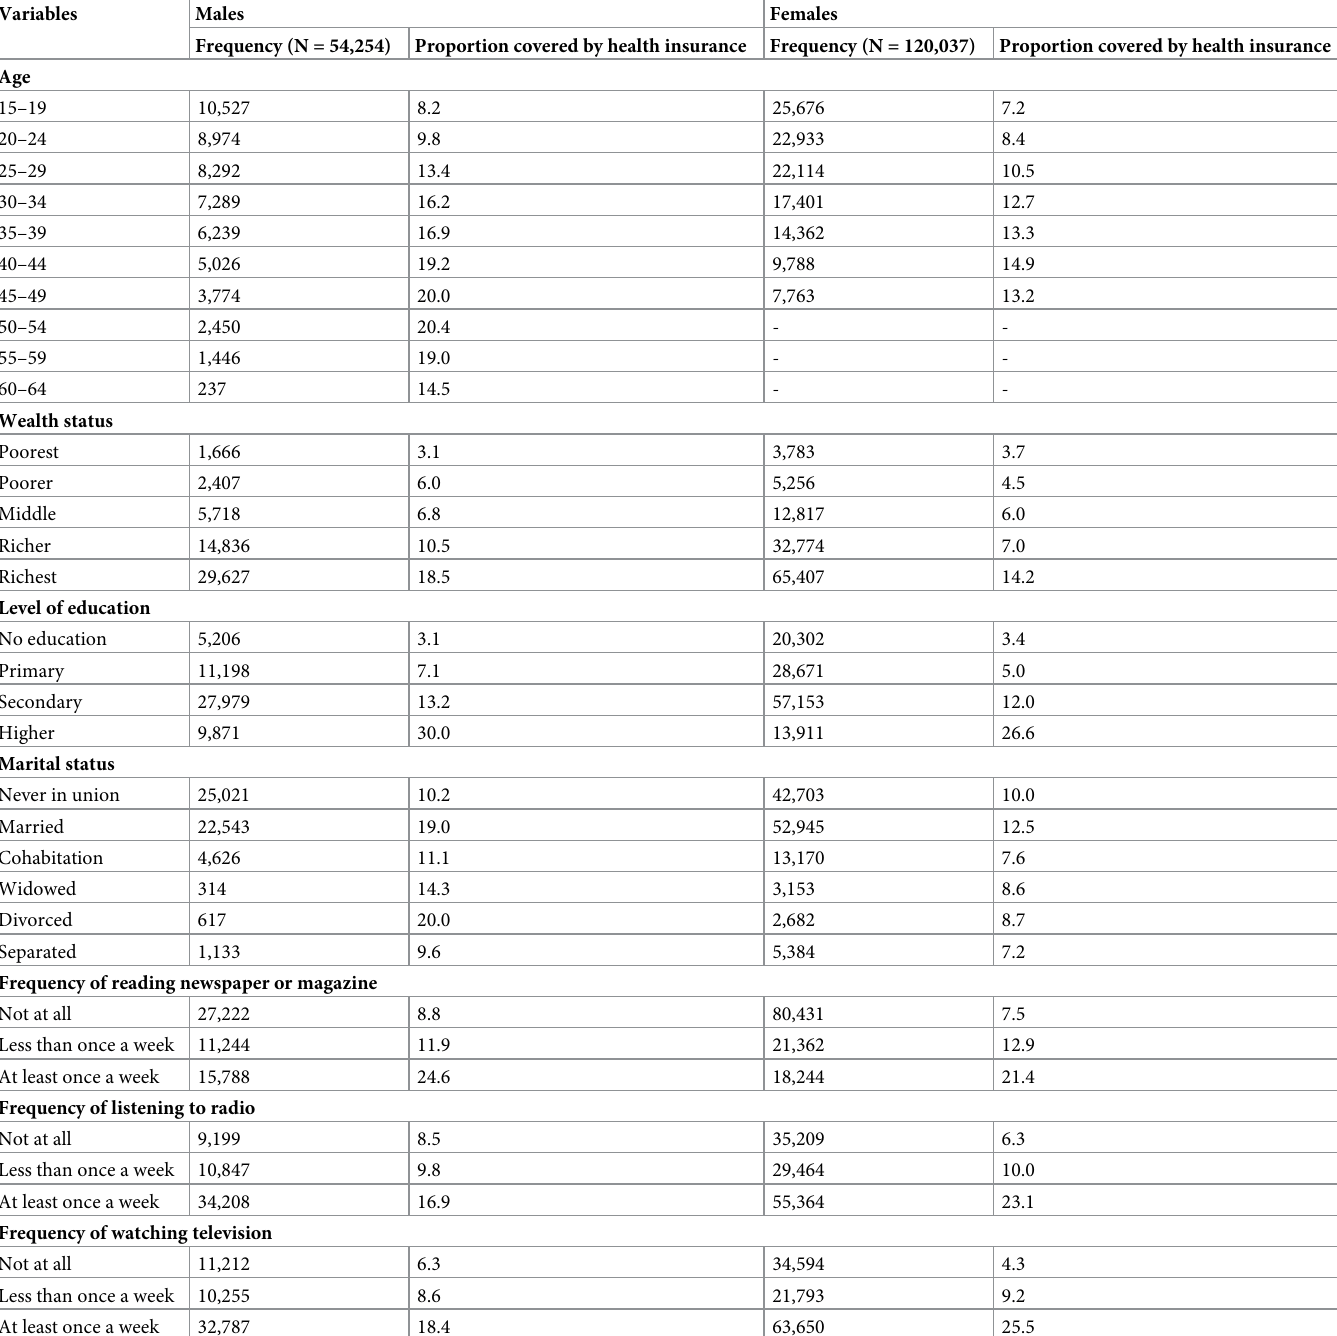
Table 1. Background characteristics and coverage of health insurance in SSA.